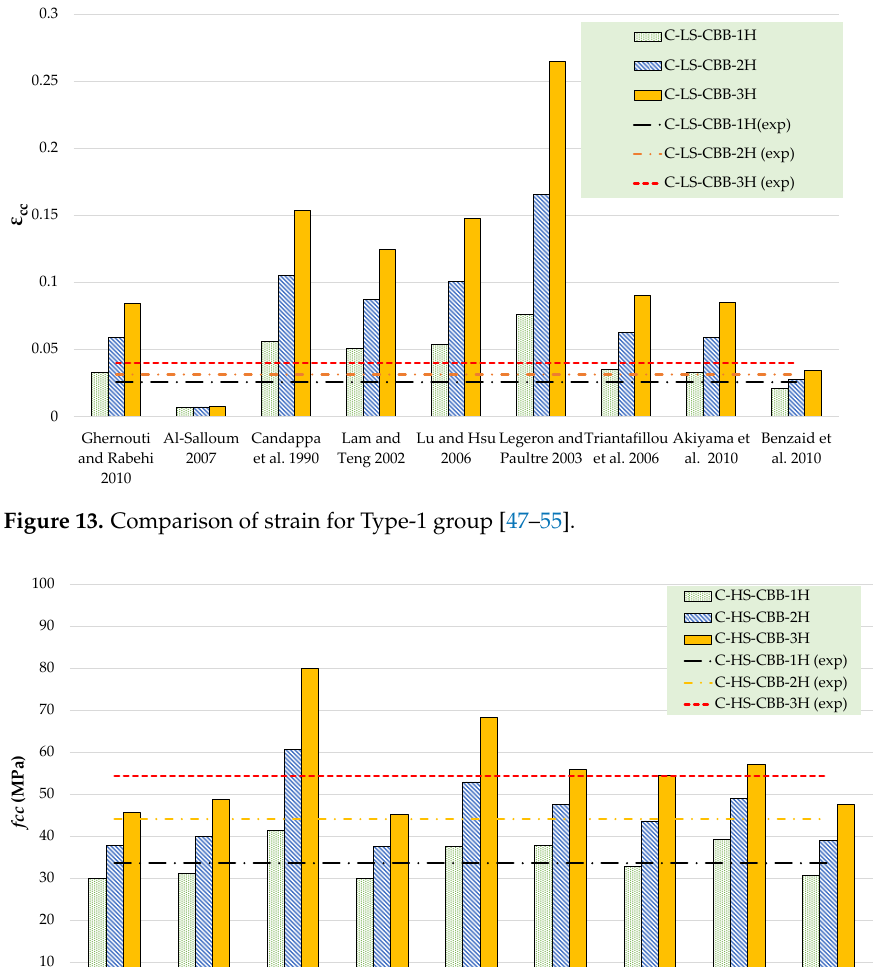
Figure 12. Comparison of strength for the Type-1 group [31 – 39].